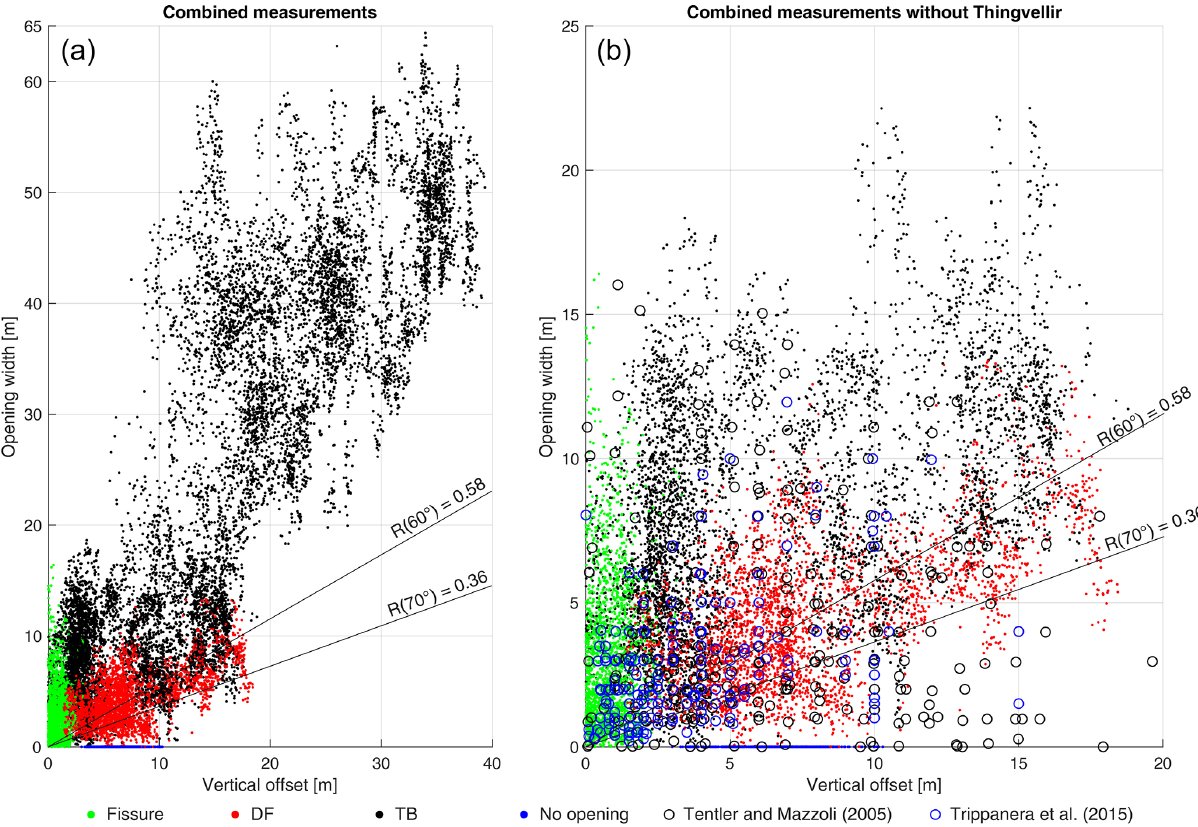
Figure 21. (a) Cumulative plots of opening width plotted against the vertical offset, including all reviewed fractures. (b) Cumulative plots of opening width plotted against the vertical offset with data from Tentler and Mazzoli (2005) and Trippanera et al. (2015), excluding Thingvellir. The straight black lines represent R for basement fault dips of 60 and 70 ◦